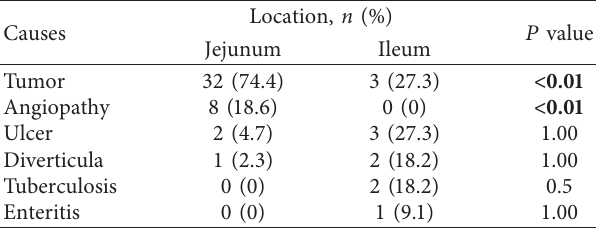
Table 3: Correlation between anatomic locations and causes of small bowel